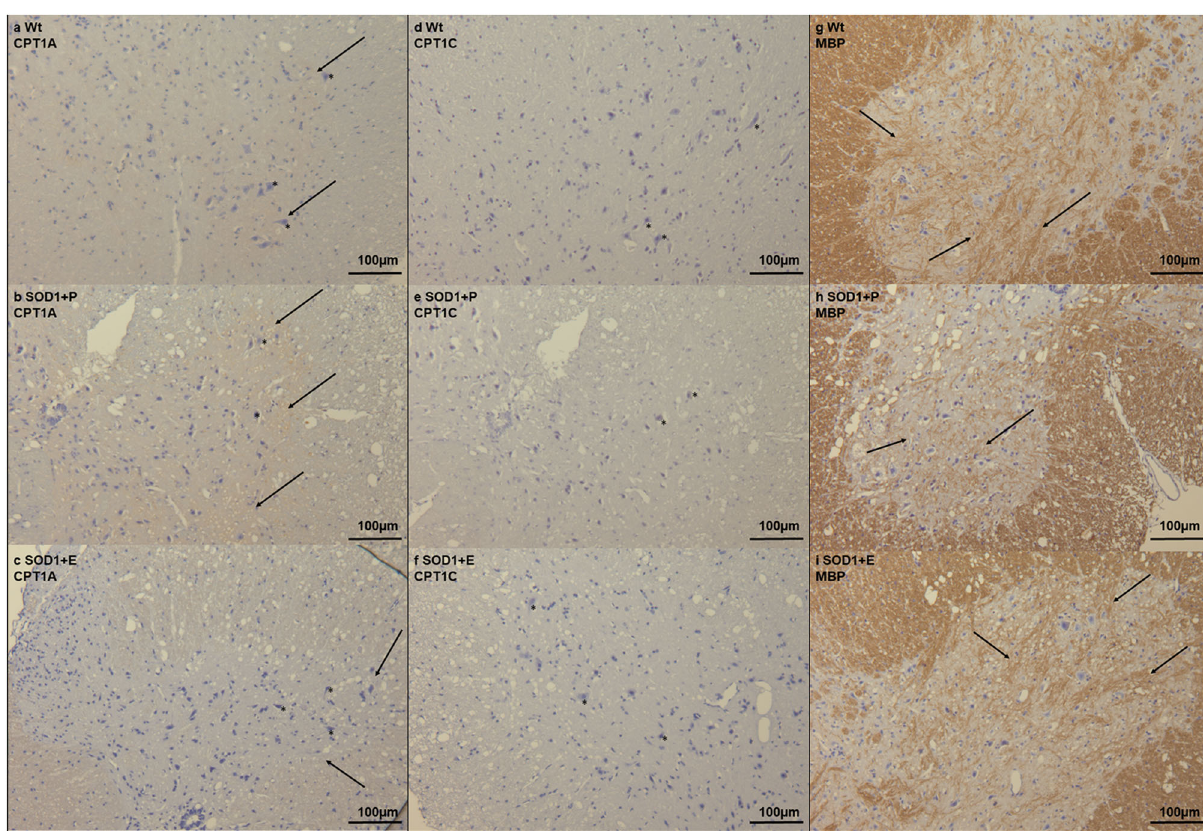
Fig. 3 Immunohistochemical staining in the lumbar spinal from the SOD1 G93A etomoxir experiment. a – c CPT1A staining in lumbar spinal cord from Wt, SOD1 + P and SOD1 + E mice at day 130 indicating increased labeling in SOD1 + P mice (arrows) and pathological morphology of neurons (asterisks). d – f CPT1C staining in lumbar spinal cord from Wt, SOD1 + P and SOD1 + E mice at day 130 indicating no difference in the labeling in SOD1 + P mice but differences in the morphology of neurons (asterisks). g – i MBP staining in lumbar spinal cord from Wt, SOD1 + P and SOD1 + E mice at day 130 indicating decreased labeling in SOD1 + P mice (arrows). All images are presented with 16x magni fi cation. N = 2 – 4 animals per group. WT = wild-type, SOD1 = SOD1 G93A genotype, E = etomoxir, P =